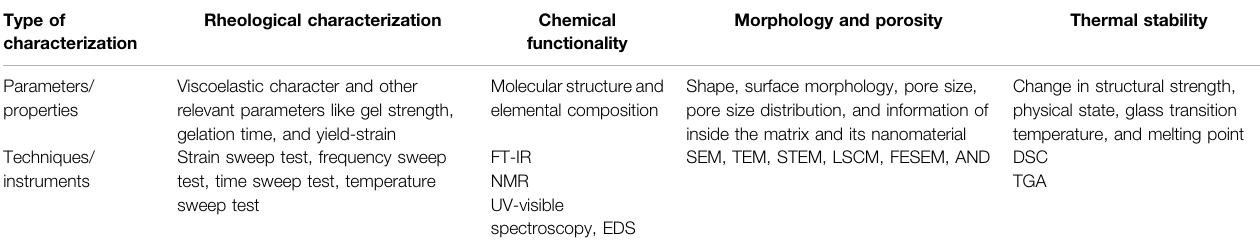
TABLE 1 | General characterization of protein-based